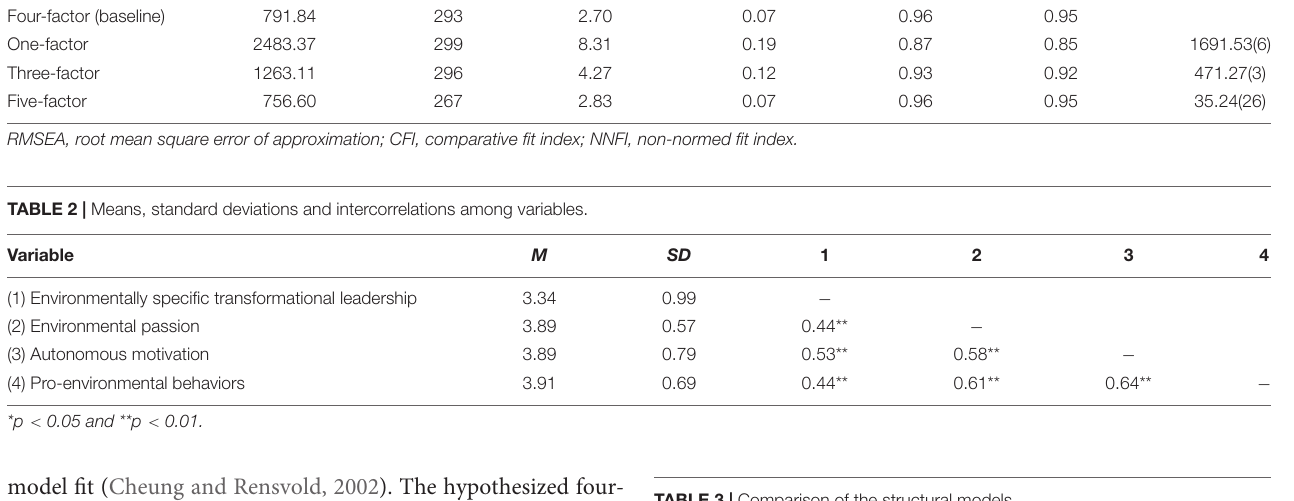
TABLE 3 | Comparison of the structural